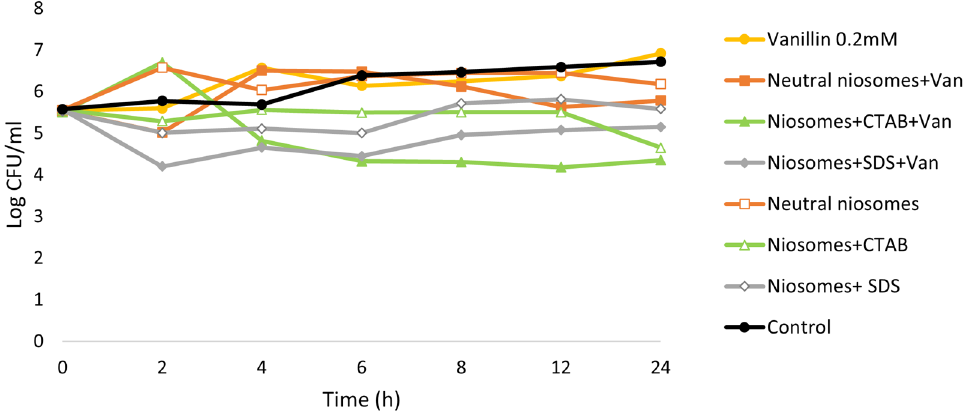
Figure 4. Time kill curves of each formulation of niosomes with and without vanillin compared to the control and free vanillin.